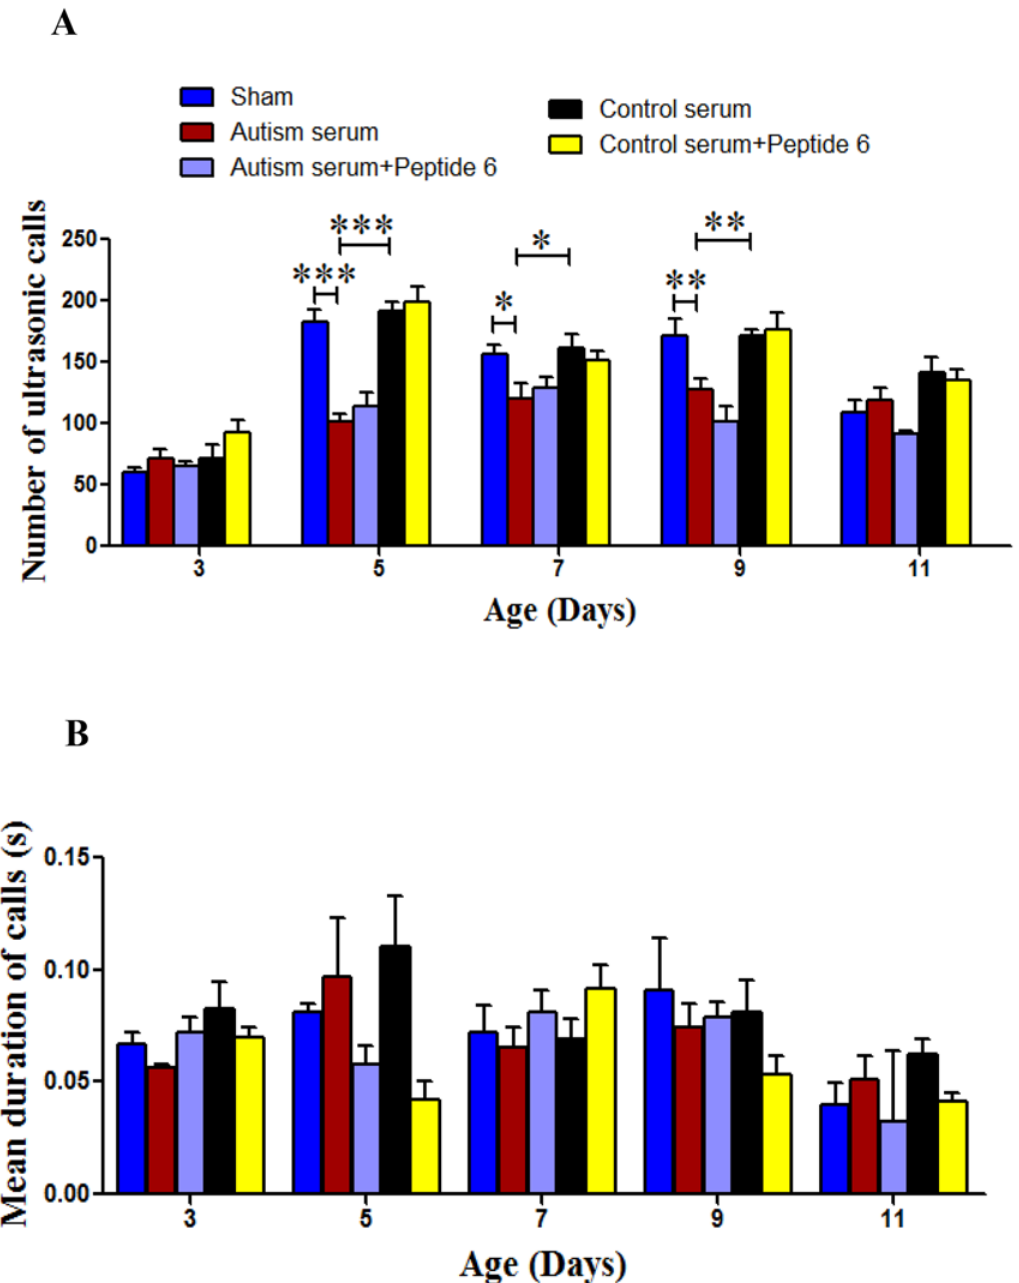
Fig 4. Effects of autism and control sera in the presence or absence of P6 on ultrasonic vocalizations (USVs) from postnatal day 2 – 11 in rat pups. ( A and B ) Social communication in young Wistar rats injected intracerebroventricularly on P 0.5 with sham or 2% autism or control serum with or without 20 nM P6. Social communication was evaluated by the number ( A ) and duration ( B ) of isolation induced ultrasonic calls emitted by rat pups during the 5min test on postnatal days 3, 5, 7, 9, and 11. Data are presented as mean ± S.E.M. in saline (sham) (n = 15 – 17), autism serum (n = 15 – 17), autism serum+P6 (n = 15 – 17), control serum (n = 15 – 17), and control serum+P6 (n = 15 – 17) treated pups. * p < 0.05, ** p < 0.01, and *** p < 0.001. ANOVA with Bonferroni ’ s post-hoc test and/or Student ’ s t